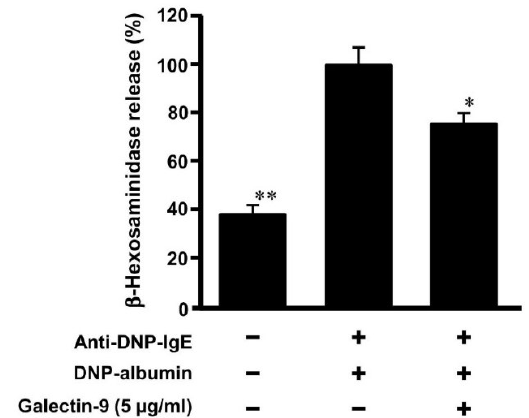
Figure 5. lgals9 mRNA expression in some tissues.Galectin-9 mRNA expression levels in colon, ileum, kidney, lung, thymus, heart, stomach, spleen and liver of mice after measurement of rectal temperature were measured. * p < 0.05 significantly different from the values of group that was injected OVA and not administrated F-fucoidan (OVA control). Values represent the means ± SEM of 4−5 mice in each group.